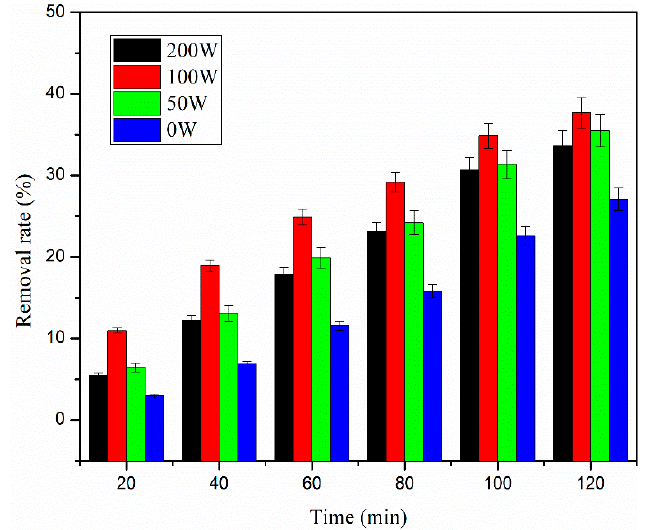
Figure 4. Effect of ultrasonic power on the removal effect of ciprofloxacin.